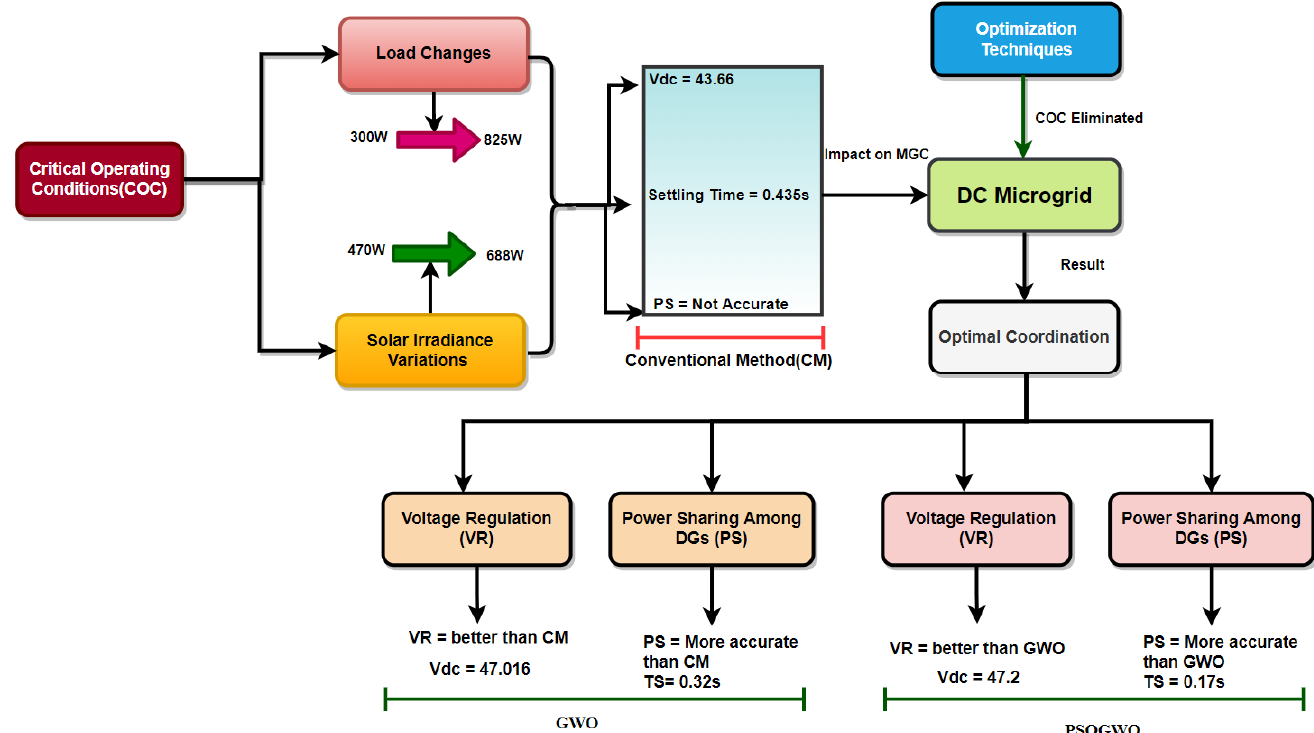
Figure 8. Summary of the main results of the proposed control technique.